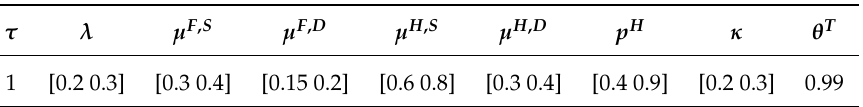
Table 2. Default parameter settings.